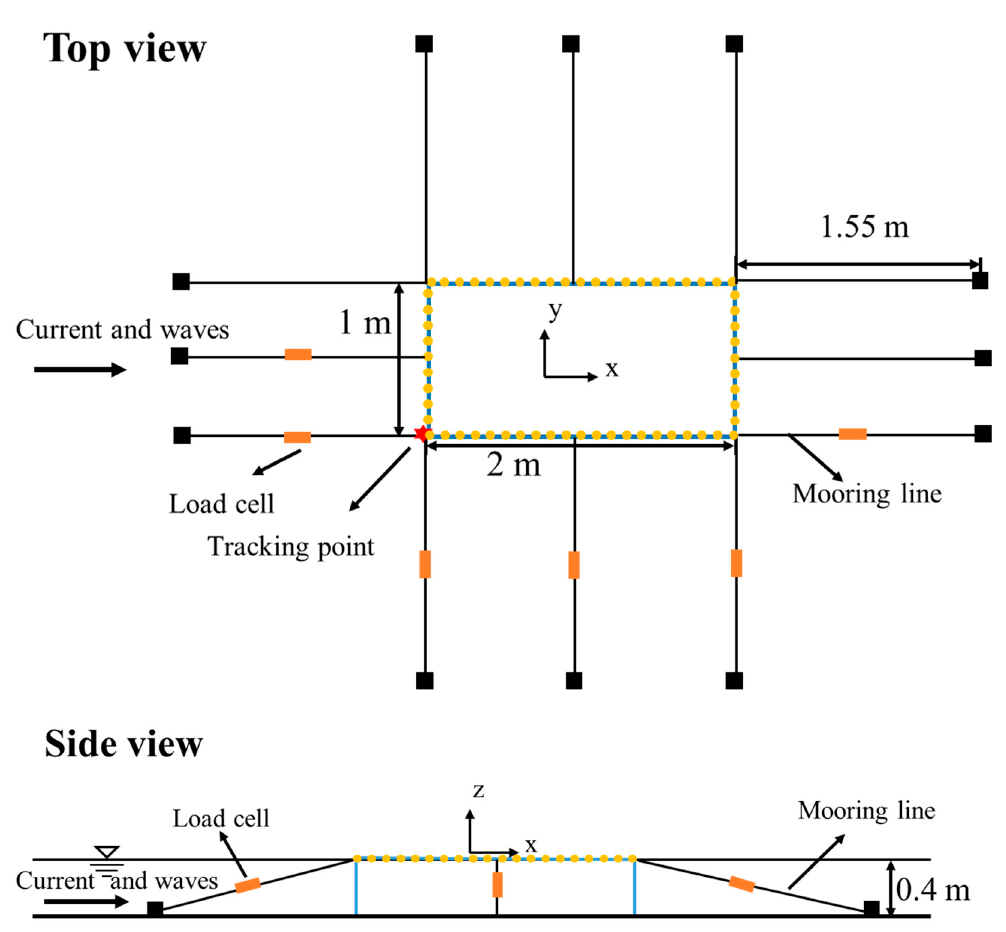
Figure 6. Model test set-up.